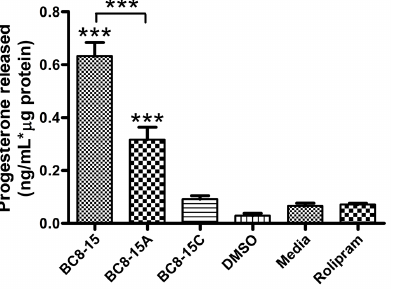
Figure 5. BC8-15 derivative elevation of progesterone release by MA-10 Leydig tumor cells corresponds with PDE8 inhibitory activity. MA-10 cells were treated with 20 m M of rolipram, BC8-15, BC8- 15A or BC8-15C. Progesterone released into the media after 2 h was measured using a progesterone ELISA kit (Neogen). The data are representative of three independent experiments with 2–4 sample wells for each condition. Values are the mean of four experimental wells 6 SEM. Data were analyzed with one-way ANOVA followed by a Tukey’s multiple comparison test (*** p , 0.001). The response to BC8-15 is significantly different from that for BC8-15A (p , 0.001) and both are significantly different from all other groups (p , 0.001).